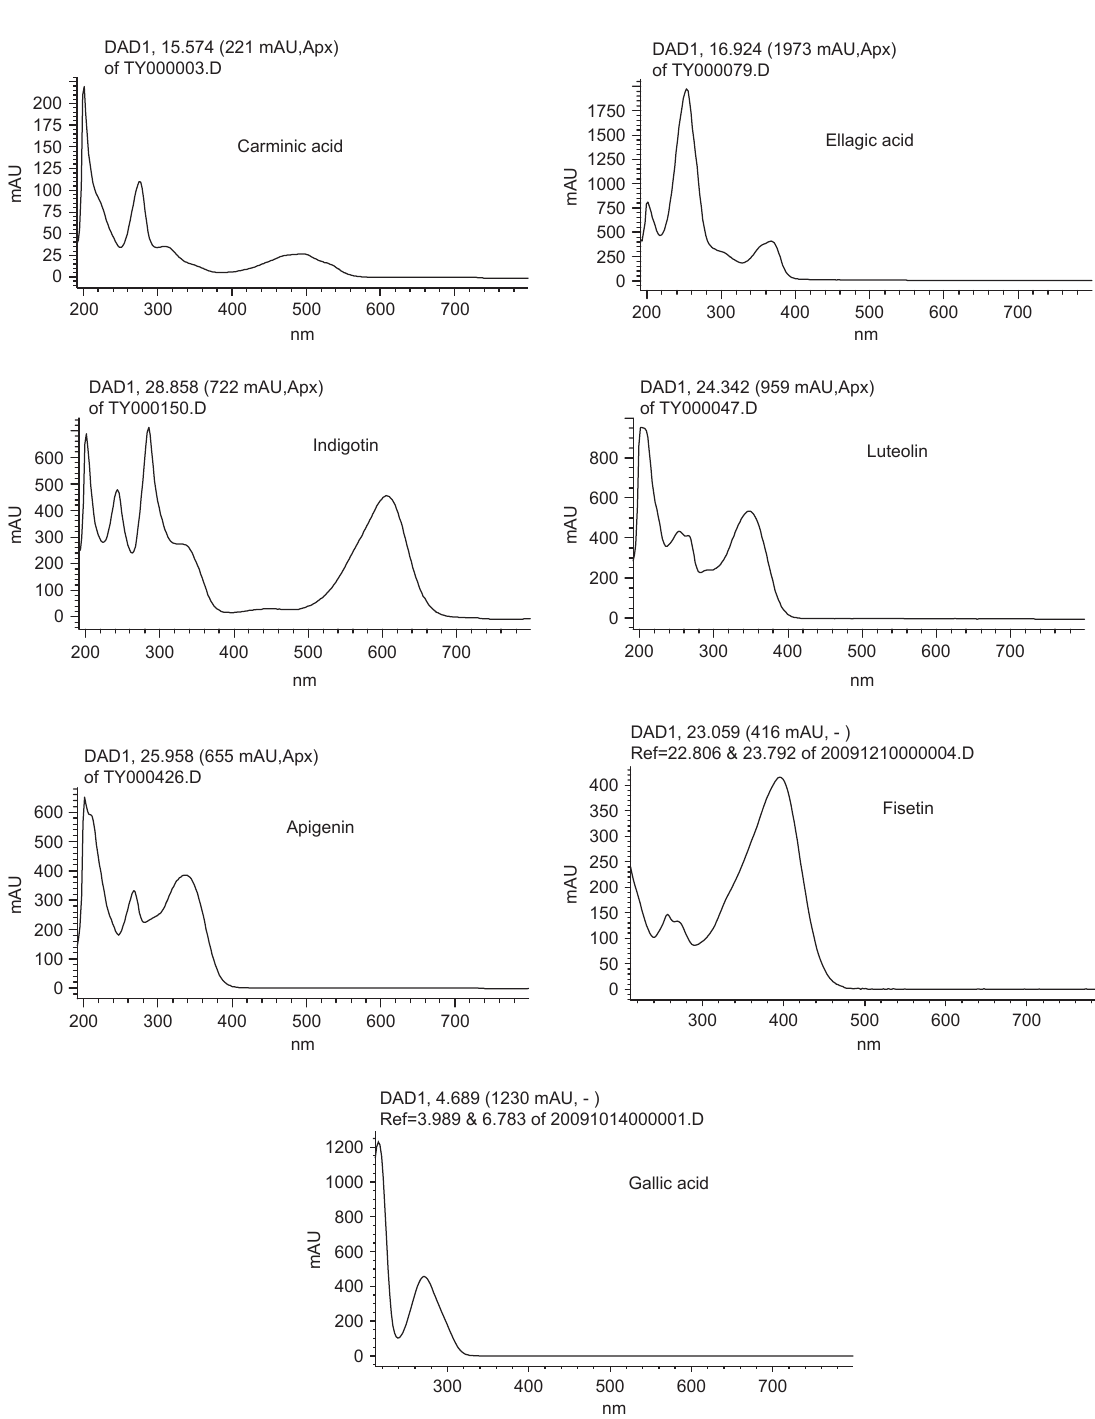
were obtained by scanning the sample from 191 to 799 nm No. WAT 086344; Waters, Ireland), protected by a guard with a resolution of 2 nm and chromatographic peaks were column fi lled with the same material, was used. Analytical monitored at 255, 268, 276, 350 and 491 nm), a G1322A and guard columns were maintained at 30 ° C. The HPLC vacuum degasser and a G1316A thermostated column com- gradient elution was performed using the method of partment; the data station was an Agilent Chemstation. A Halpine et al. ( 1996 ) and Karapanagiotis et al. ( 2005 , 2009 Nova-Pak C analytical column (3.9 × 150 mm, 4 µ m, Part 18